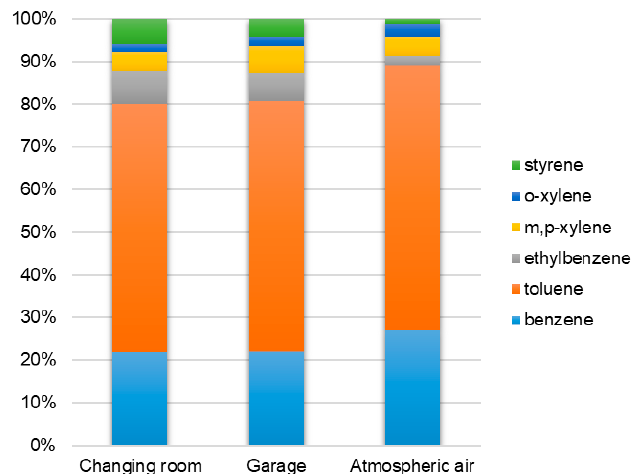
Figure 1. Mean profiles of the BTEXSs in the indoor (changing room and garage) and outdoor air at the selected fire station in Poland.